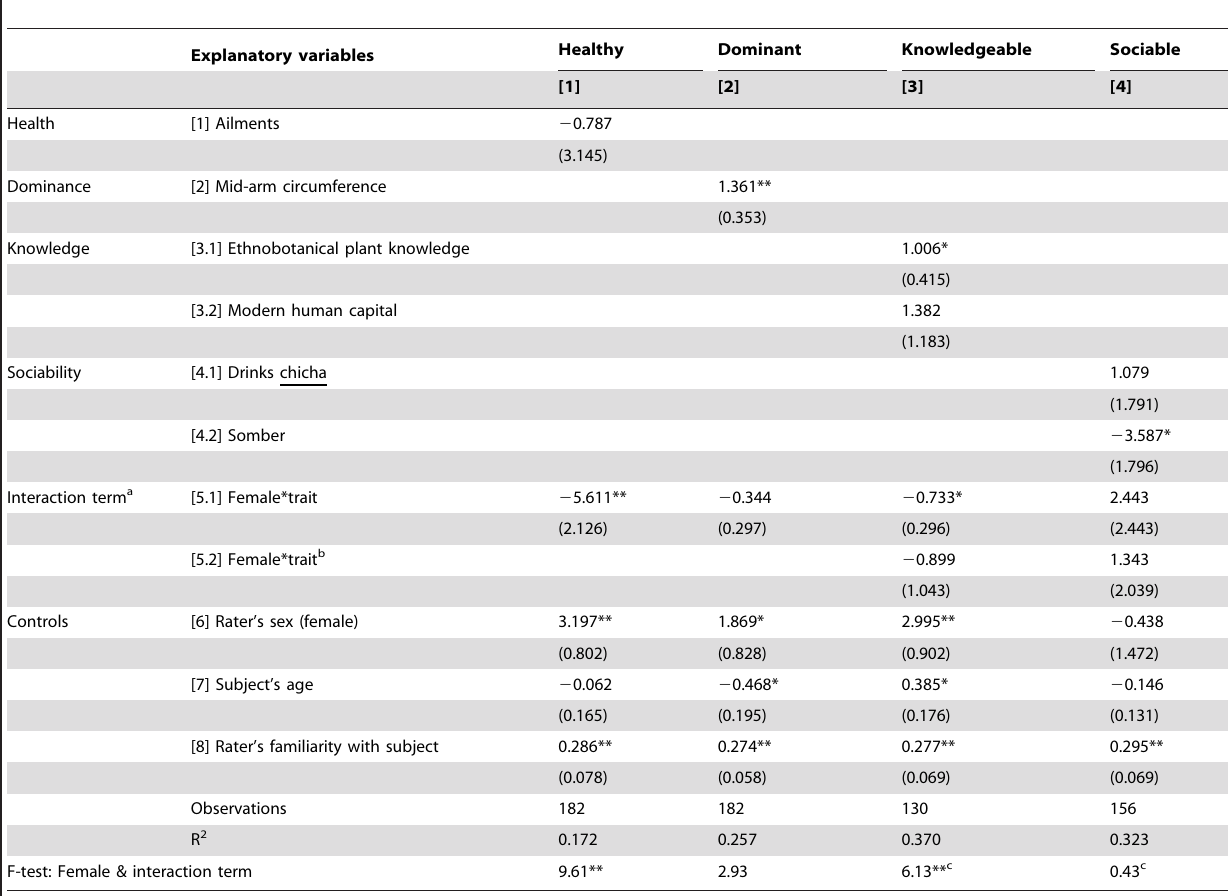
Table 3. Regression results for mean ratings of the following perceived traits from facial photographs: healthy [1], dominant [2], knowledgeable [3], and sociable